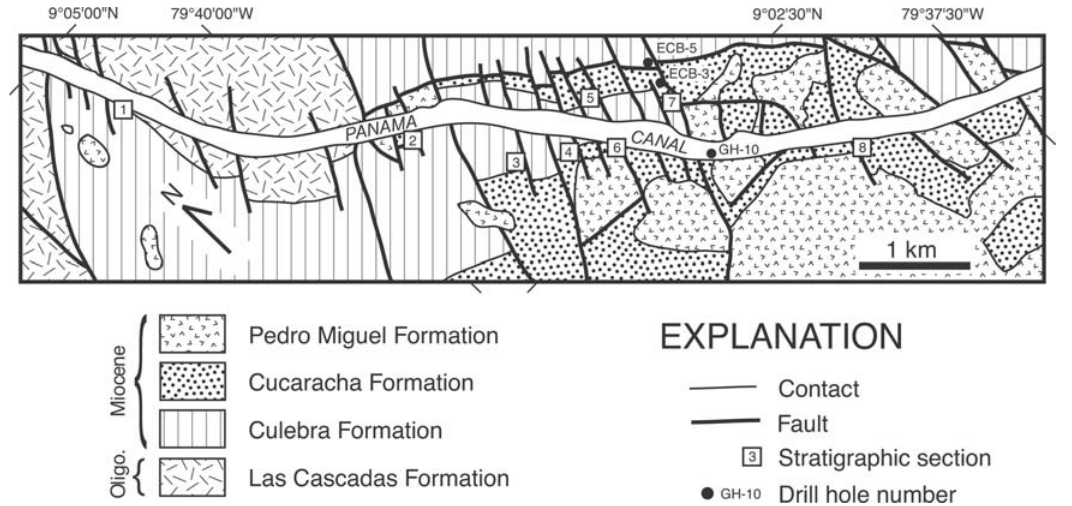
Figure 3. Geologic map of the study area along the Gaillard Cut portion of the Panama Canal, within the Panama Canal Basin (see rectangle labeled ‘A’ in Figure 2). Geology modified from Stewart et al. [27]. Oligo.=Oligocene.